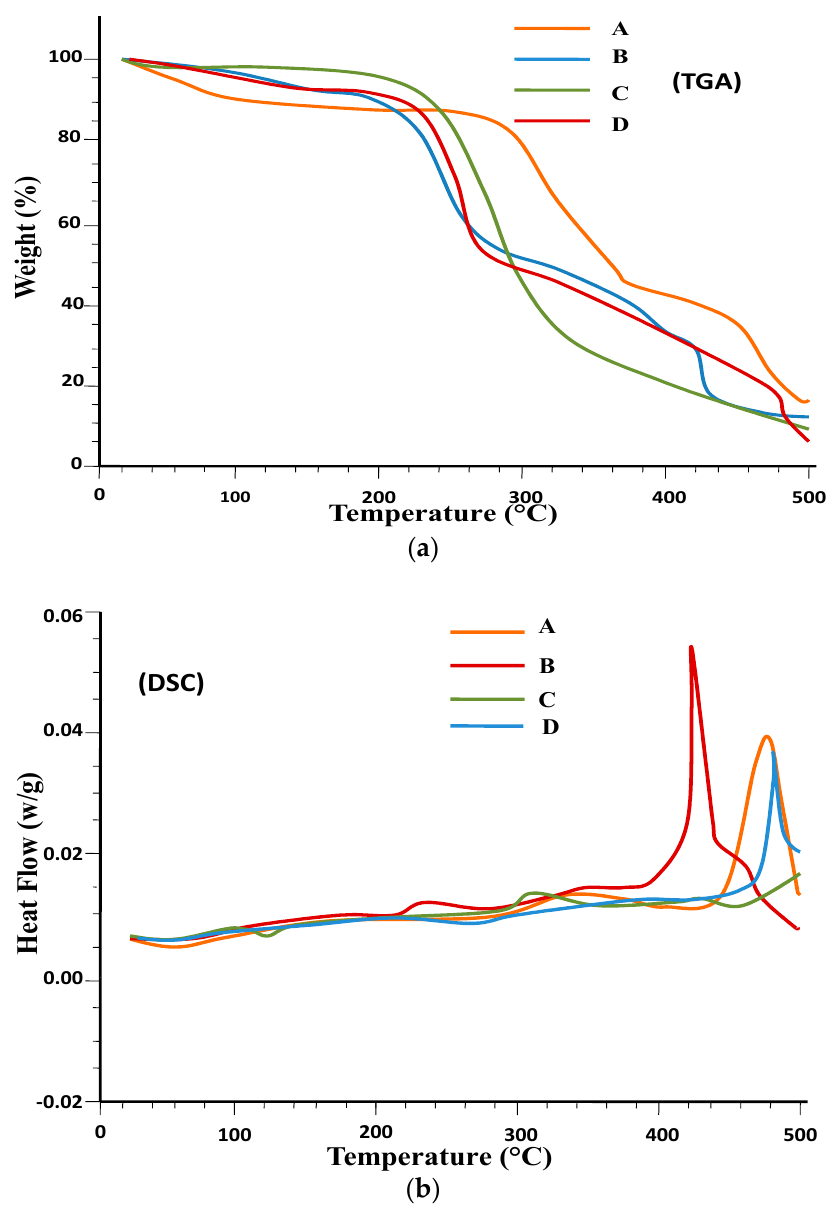
Figure 3 . ( a ). TGA of (A) captopril; (B) BSG; (C) BSG-co-poly (AA)-unloaded hydrogel; (D) BSG-co-poly (AA)-loaded hydrogels, ( b ). DSC of (A) captopril; (B) BSG; (C) BSG-co-poly (AA)-unloaded hydrogel; (D) BSG-co-poly (AA)-loaded hydrogels.